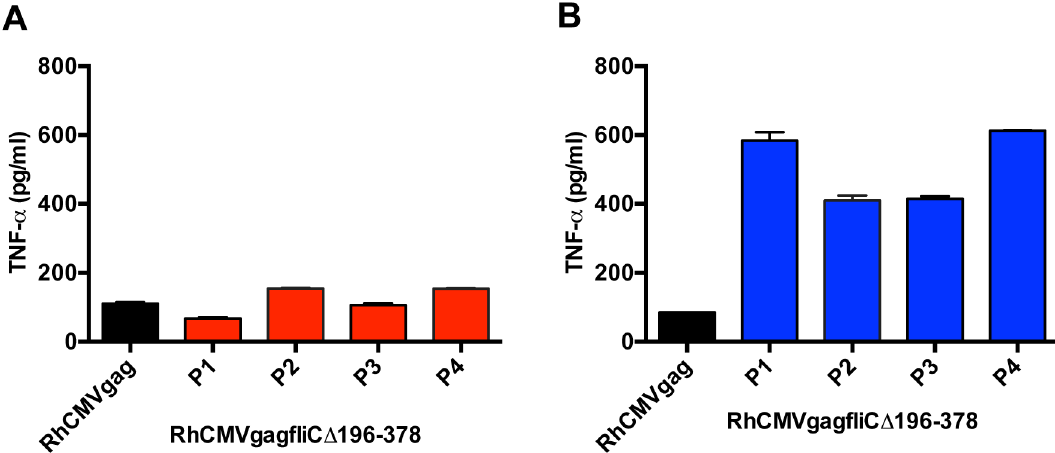
Fig 5. RhCMV gagfliC Δ 196 – 378 serial passage in TeloRF cells. RAW264.7 cells (A) or RAW424 cells (B) were treated with lysates from TeloRF cells infected with RhCMV gag (black bars) or RhCMV gagfliC Δ 196 – 378 upon serial passage. Cell culture supernatants were collected after four hours of treatment and analyzed for TNF- α by ELISA. Data represent means with standard